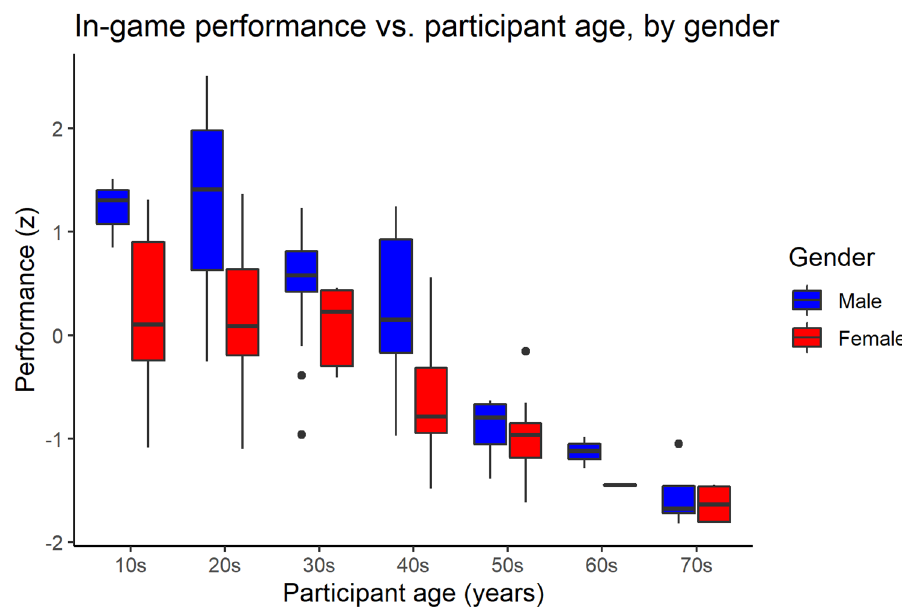
Figure 3. Box plot of player performance grouped by age group and separated by gender. Bold lines indicate median value; box bounds represent first and third quartile, while dots represent outliers based on interquartile range. In both genders average performance is comparable across younger age groups but is noticeably lower beginning with a specific age group (40 s for women, and 50 s for